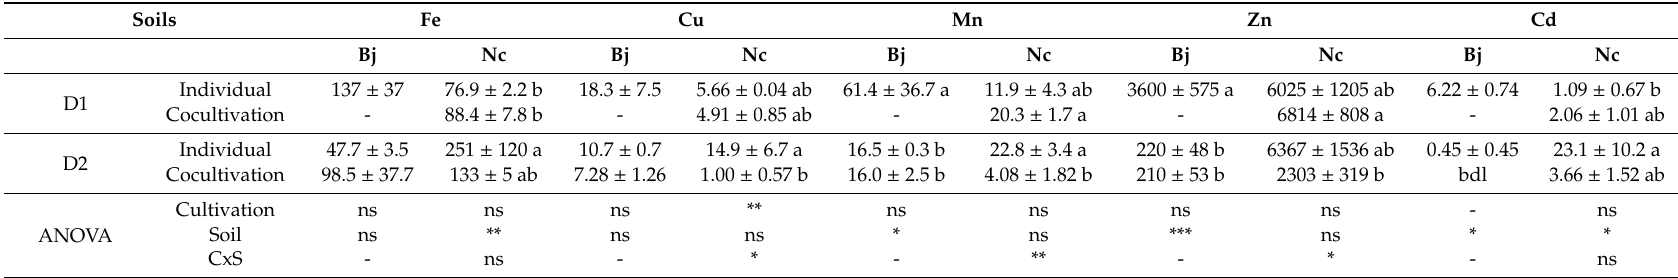
Table 3. Heavy metal concentrations in the plants from Experiment 1 ( µ g g − 1 DW), B. juncea (Bj) and N. caerulescens (Nc), grown individually and under cocultivation ( n =